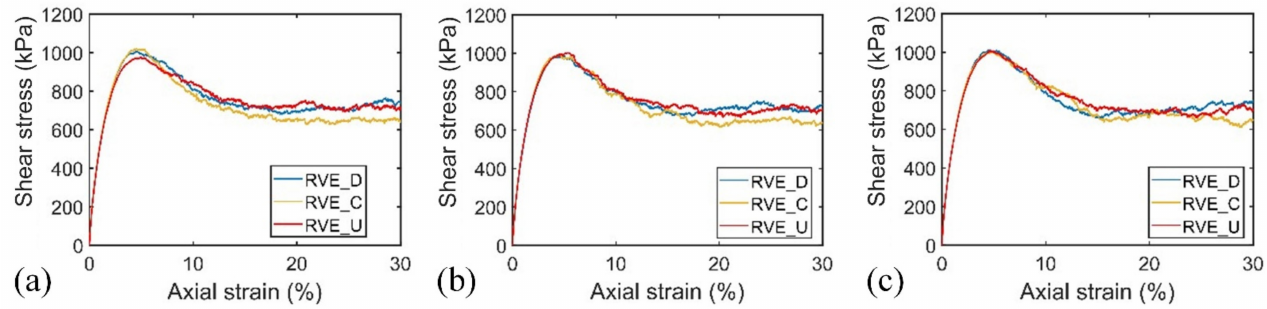
Figure 14. Stress–strain behavior for the specimen FC40 at t = ( a ) 0.0 s; ( b ) 0.1 s; and ( c ) 0.2 s.